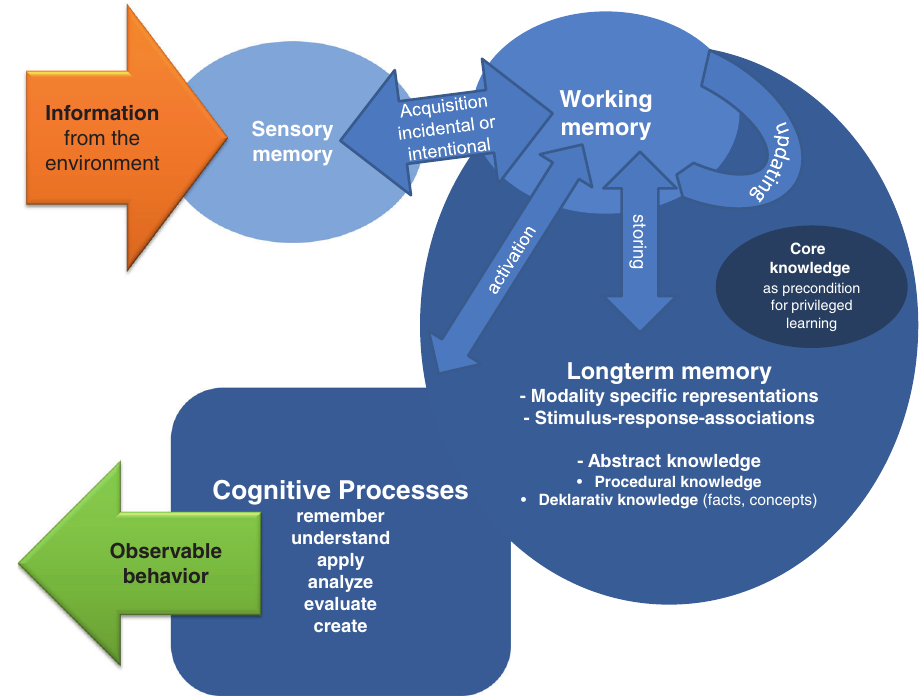
Fig. 1 A model of human information processing, developed together with Dr. Lennart